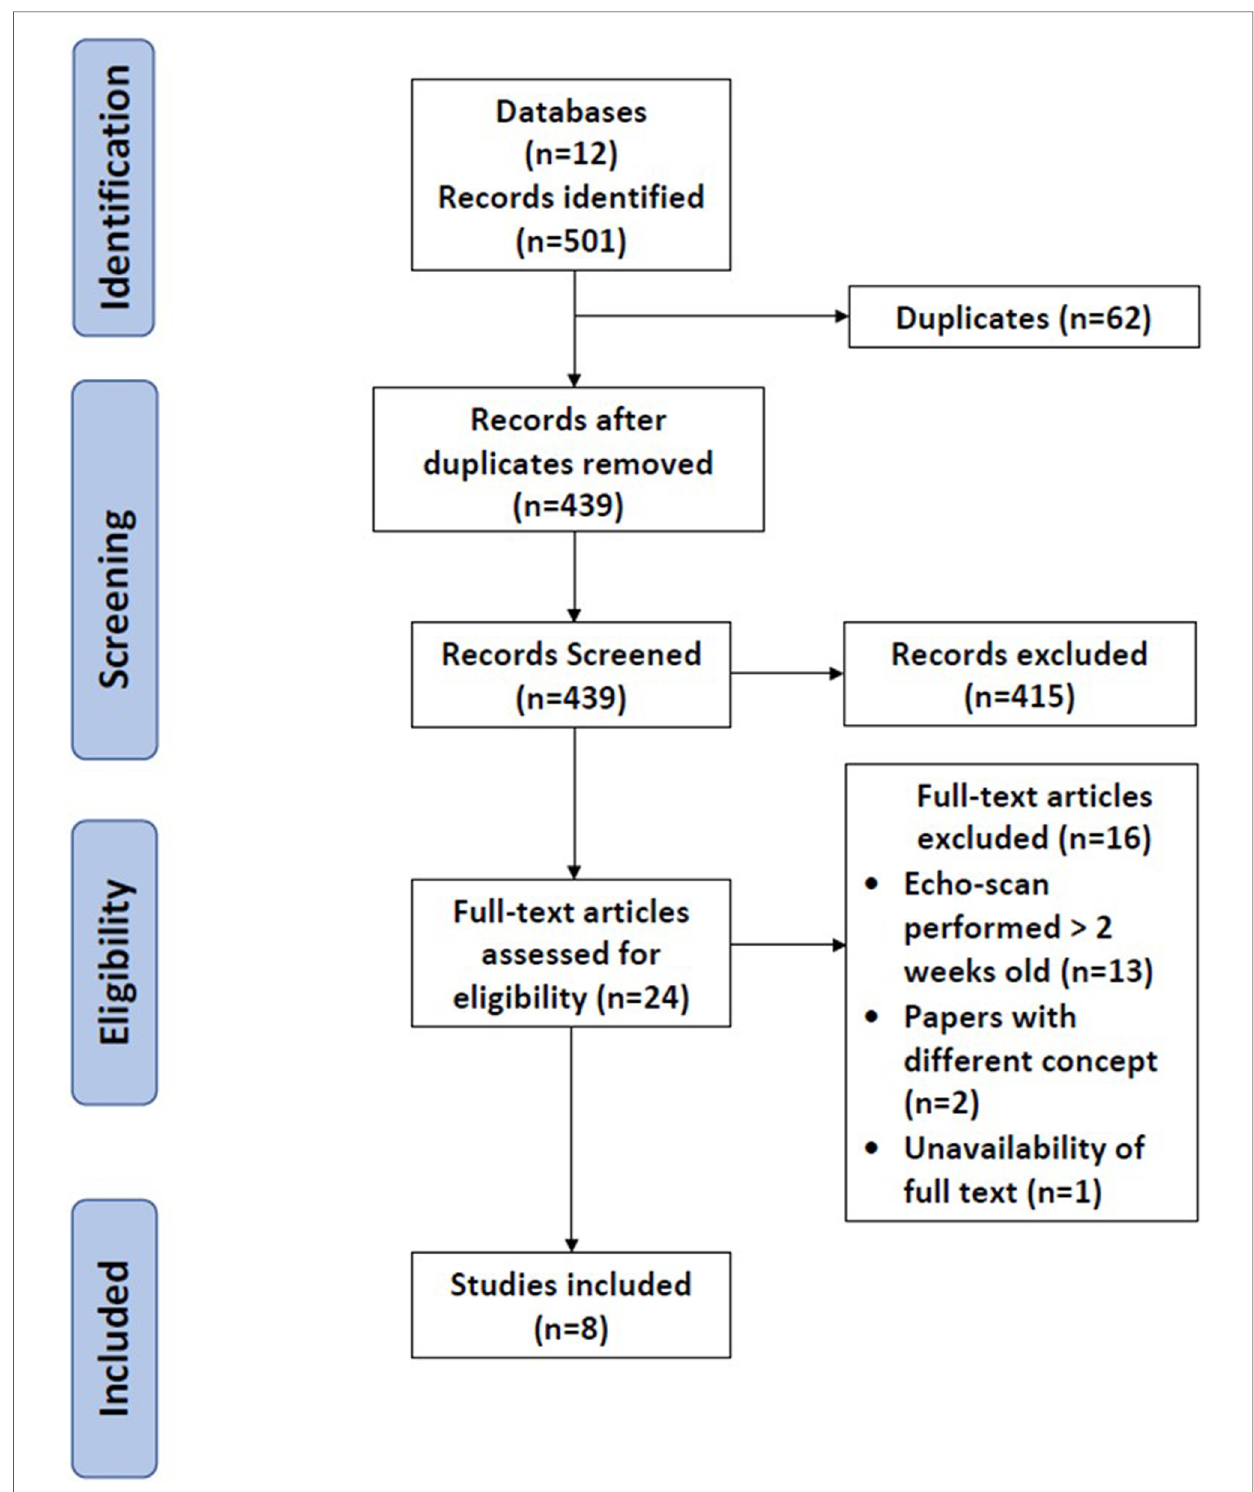
FIGURE 1 PRISMA fl ow